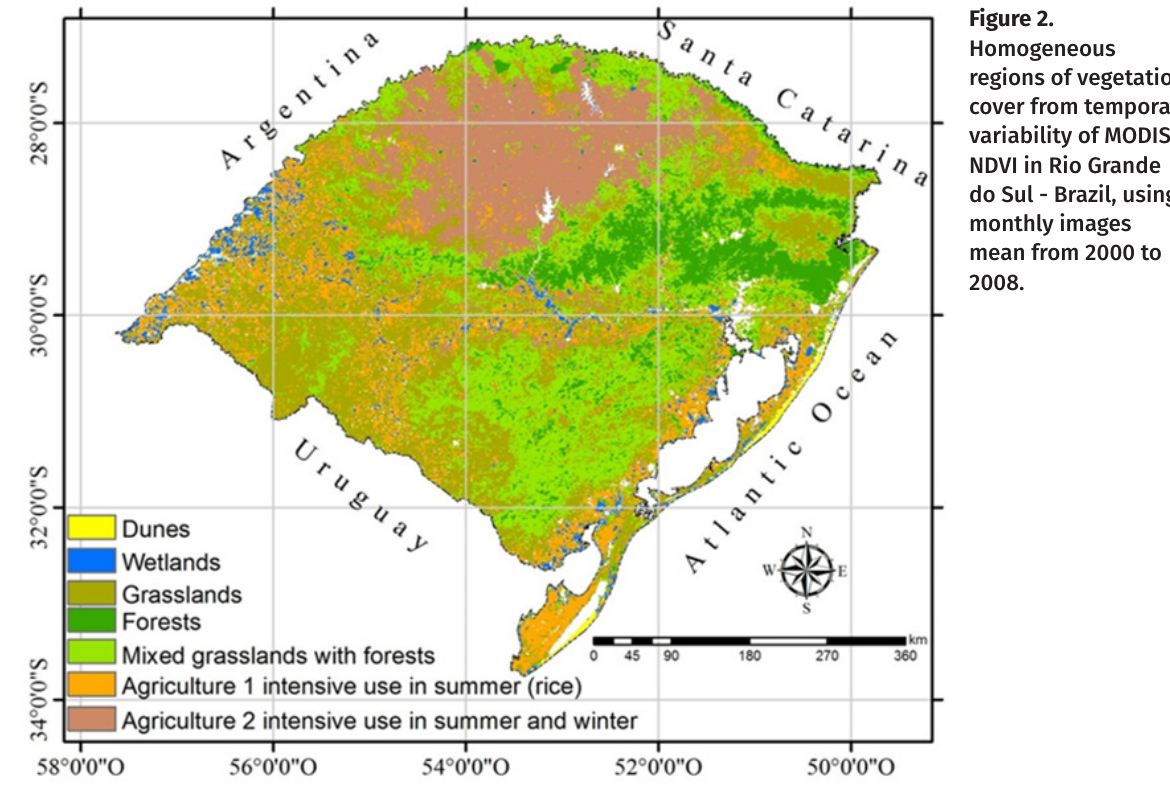
Figure 2. Homogeneous regions of vegetation cover from temporal variability of MODIS NDVI in Rio Grande do Sul - Brazil, using monthly images mean from 2000 to